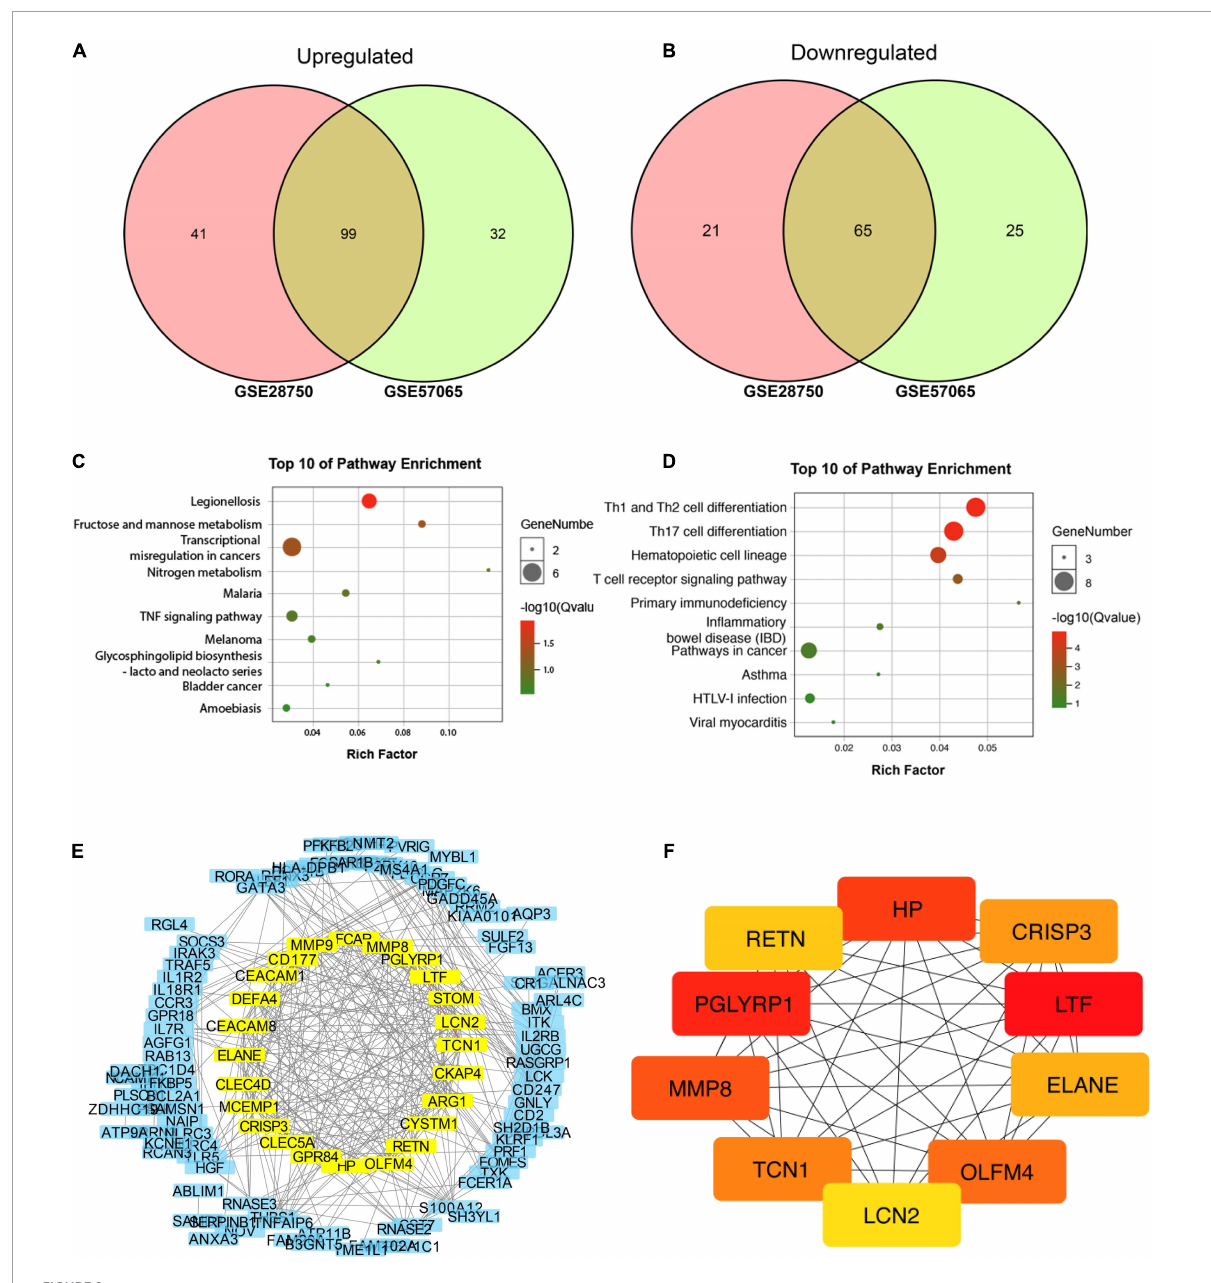
FIGURE2 Bioinformatic identification based on gene expression omnibus (GEO) database. (A,B) Venn diagram of 99 common upregulated and 65 common downregulated DEGs. (C) Top 10 pathways enriched by GO. (D) Top 10 pathways enriched by KEGG. (E) Protein-protein interaction (PPI) network for discovering hub genes. (F) Top 10 molecules in network string interactions ranked by maximal clique centrality (MCC) method.